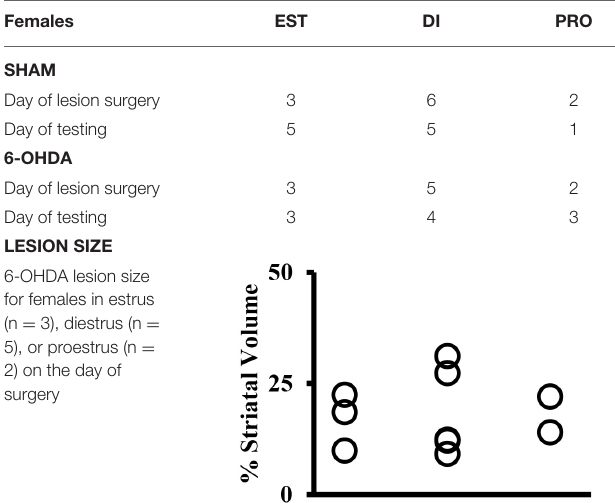
TABLE 1 | Above: Table showing the numbers of sham-operated (SHAM) and 6-hydroxydopamine (6-OHDA) lesioned female rats identified by vaginal cytology as being in estrus (EST), diestrus (DI), or proestrus (PRO) on the day that SHAM or 6-OHDA lesions were made (Day of Surgery) and on the day of testing for the What-Where-When Episodic-like memory task (Day of Testing).